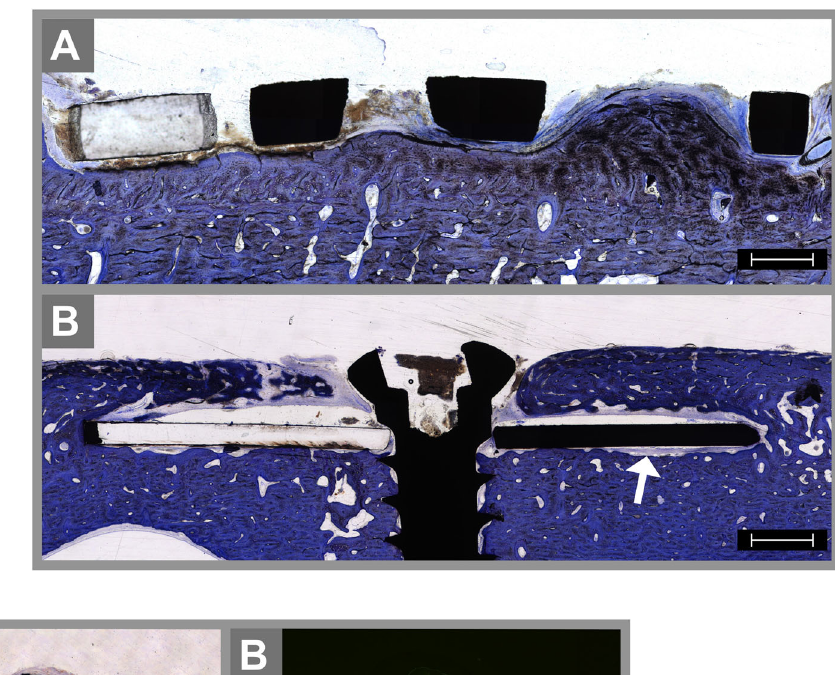
Fig. 3 Histological specimens of subperiosteal implants after 16 weeks stained with toluidine blue. The titanium mesh had direct contact with the surface of the frontal bone and presented with some connective tissue ingrowth between the struts and little appositional bone growth at the edges of the implant ( A ).